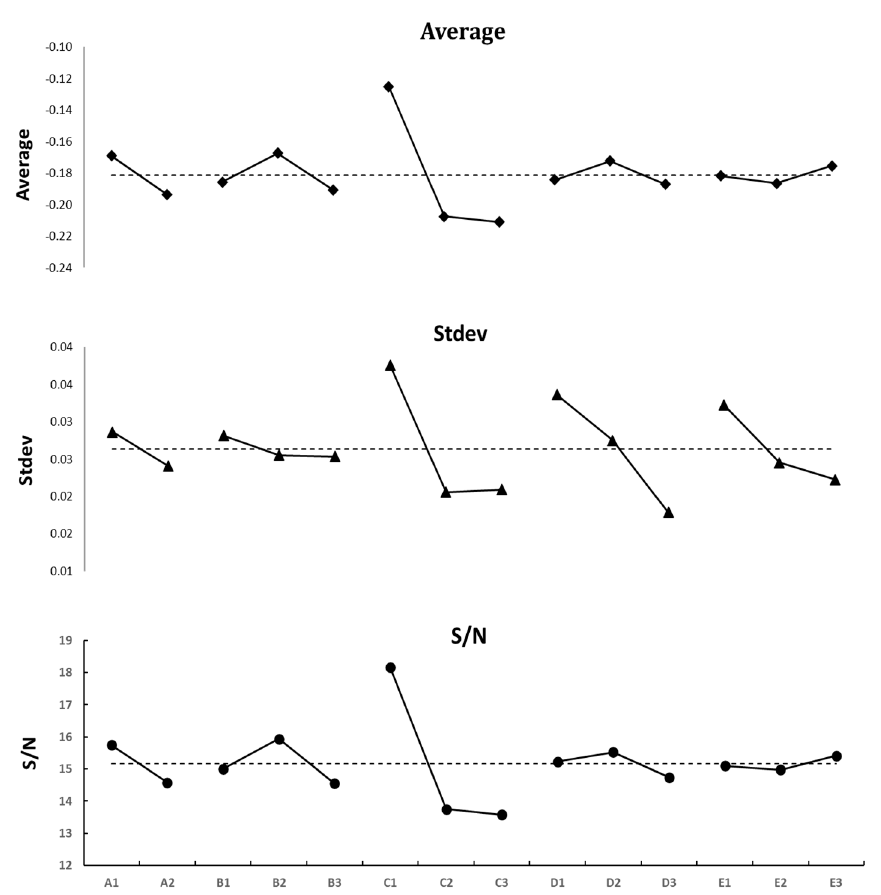
Figure 2. The respective three fish-bone plots of the sonography scan protocol. Apparently, factor C (frame rate) has the dominant contribution among all factors.